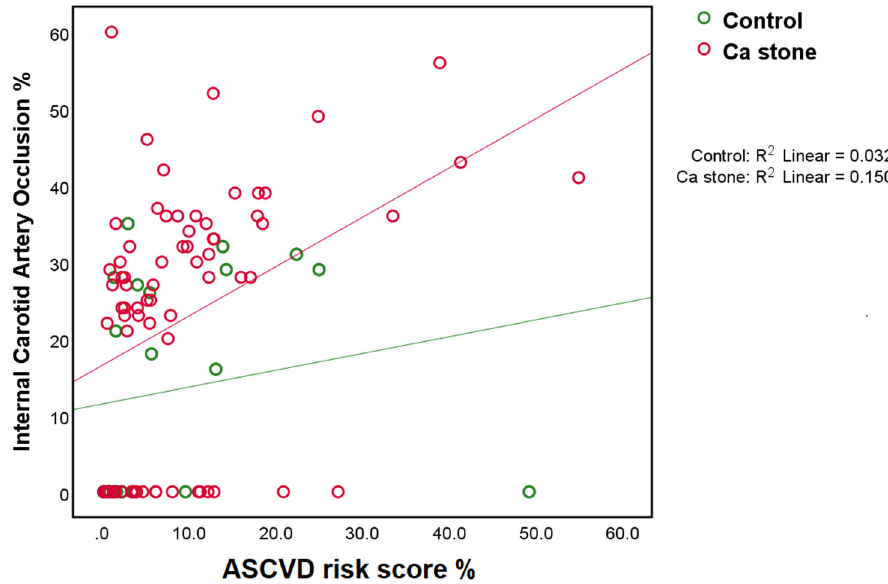
Figure 1. Scatter plot of ASCVD risk score versus carotid artery stenosis (%) with linear regression. The square of the correlation coefficient (r2) with significance ( p value) is presented in the box.